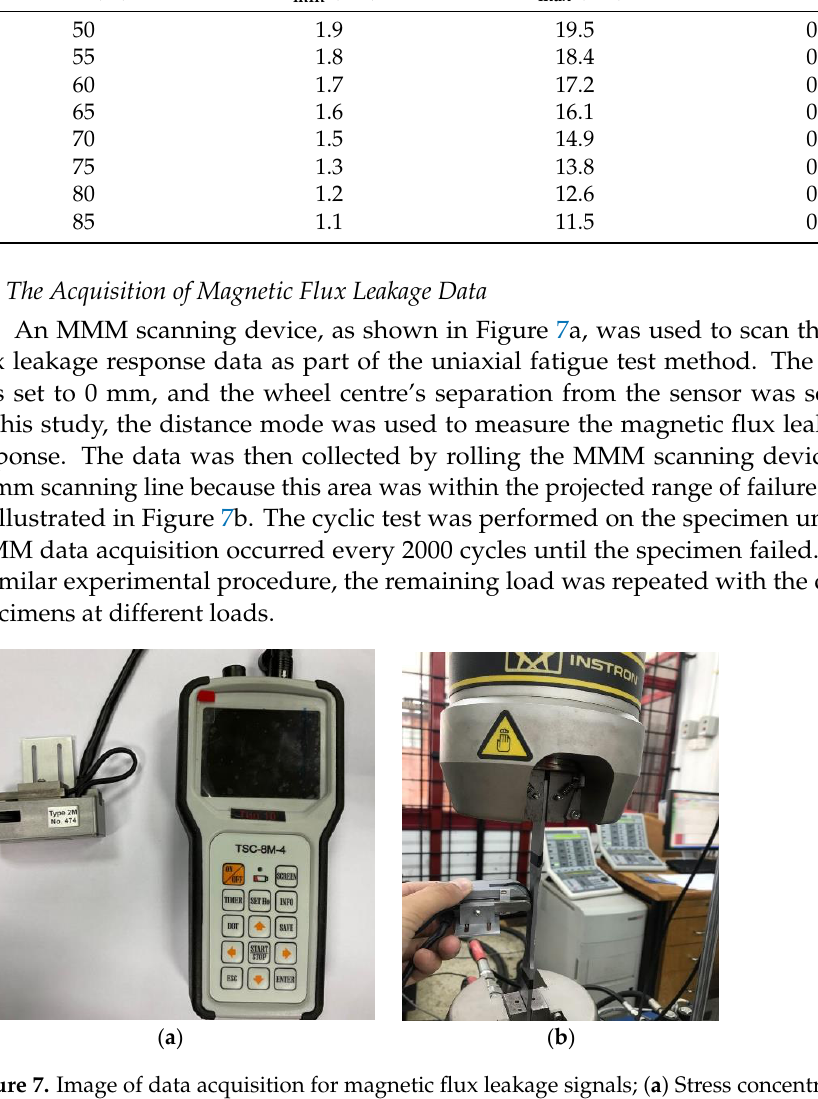
Figure 7. Image of data acquisition for magnetic flux leakage signals; ( a ) Stress concentration testing device for the identification of magnetic flux leakage signals, ( b ) Signal acquisition activity during a cyclic